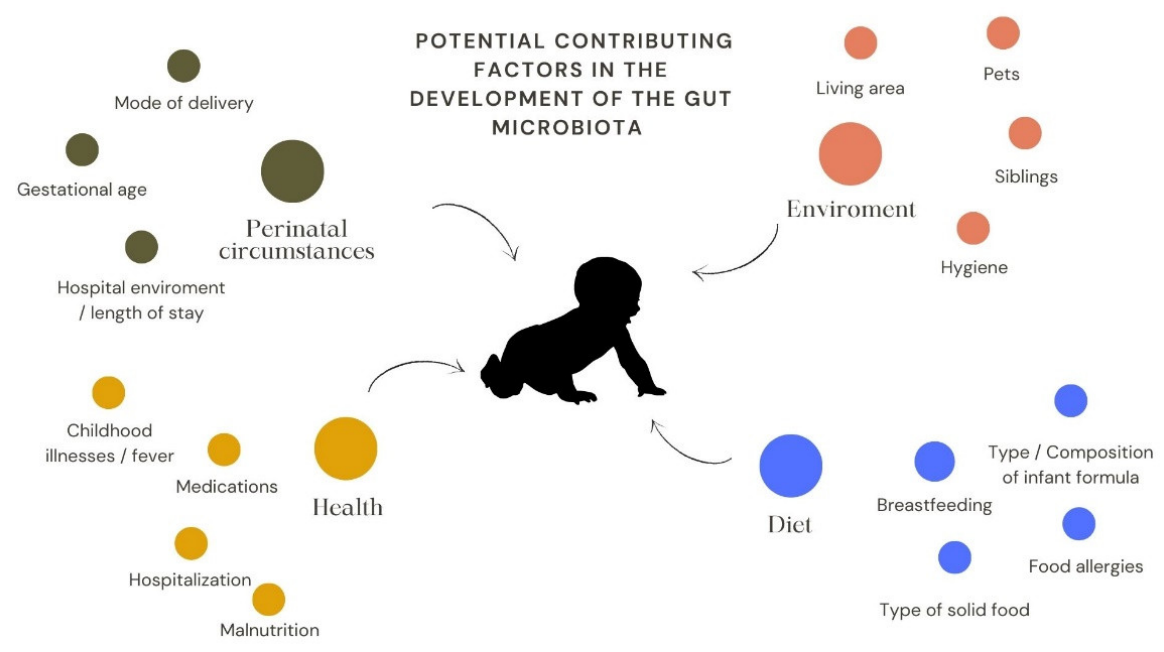
Figure 3. Potential contributing factors in the development of the gut microbiota. The most important factors can be grouped as perinatal circumstances, health-related, environmental and dietary factors.